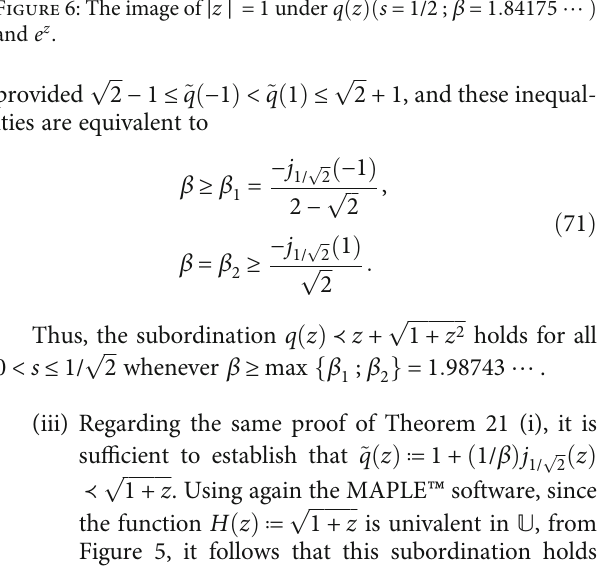
Figure 6: The image of ∣ z ∣ = 1 under q ð z Þð s = 1/2 ; β = 1 : 84175 ⋯ Þ and e z